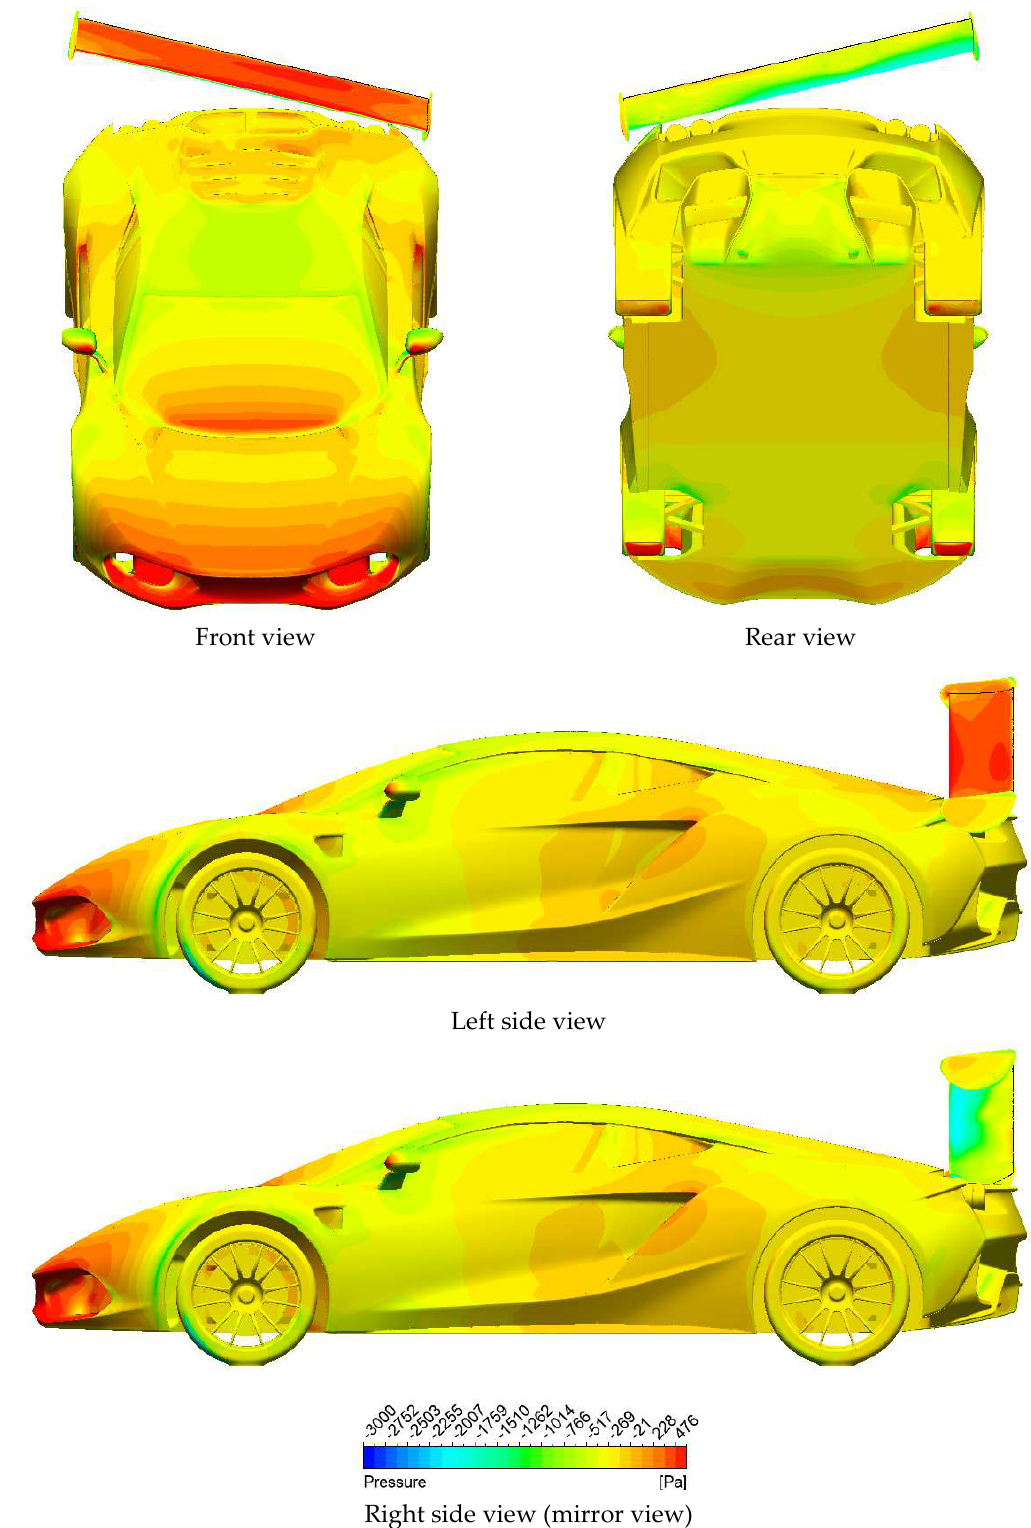
Figure 20. Pressure distribution on car in different views.